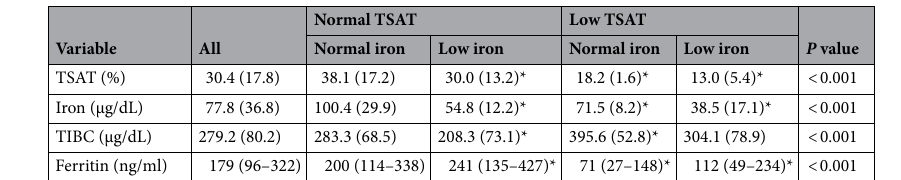
Table 2. Iron status divided by TSAT and serum iron in CKD 1–4 patients. Data were presented as mean (standard error), median (interquartile range), or count (percentage). P value column meant differences among groups (< 0.05 was significant). *Meant significant difference (P < 0.05) compared with normal TSAT normal iron group in post hoc analysis. The significance of differences for normally-distributed continuous variables among groups was tested using one-way ANOVA with post hoc analysis by Fisher’s least significant difference test and, for non-normally-distributed continuous variables, it was tested using Kruskall–Wallis analysis with post hoc analysis by Dunn–Bonferroni method. The difference in the distribution of categorical variables among groups was tested using the Chi-square test with post hoc analysis by Bonferroni